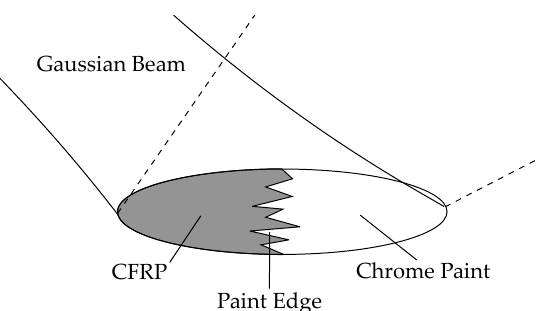
Figure 13. Model of the paint edge under the illuminated spot. The paint edge is not a straight line but rough.